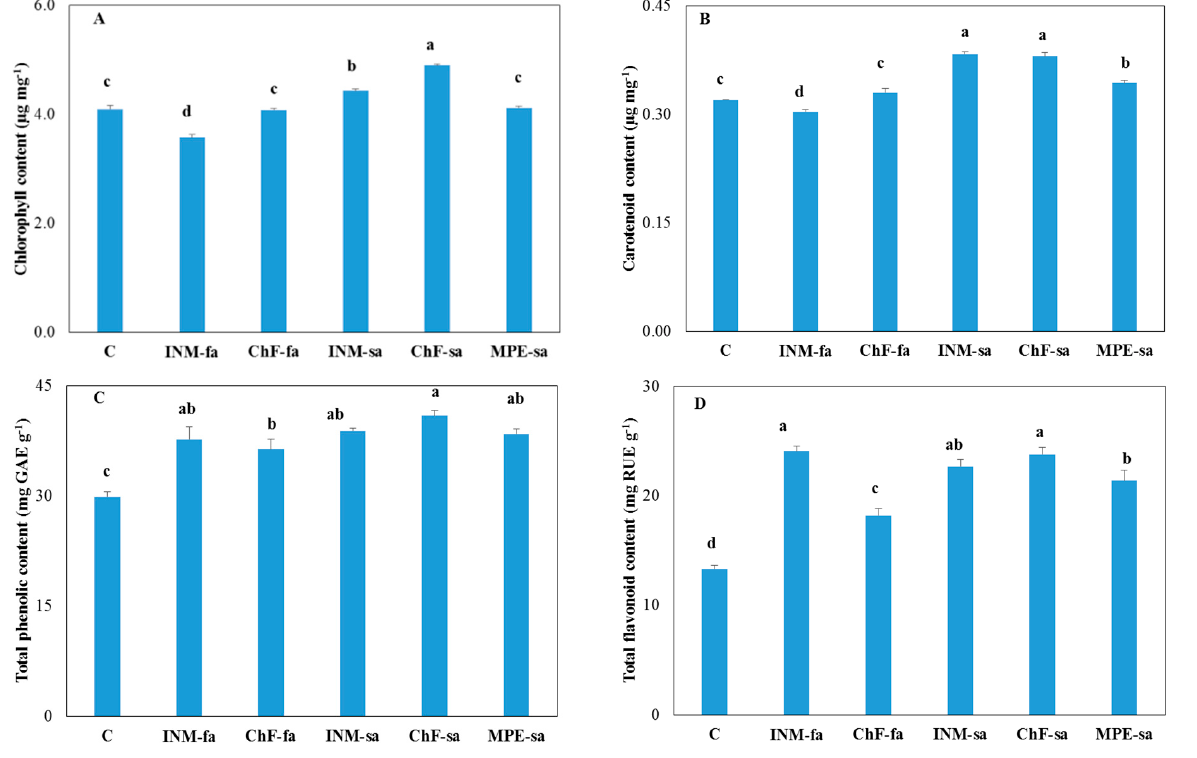
Figure 4. Effect of fertilization through different (root/foliar) application methods on: ( A ) leaf chlorophyll; ( B ) carotenoid; ( C ) total phenol; ( D ) total flavonoid content of Origanum microphyllum . C: control (water); INM: integrated nutrient management (INM) by foliar (INM-fa) or soil application (INM-sa); ChF: conventional fertilization by foliar (ChF-fa) or soil application (ChF-sa); MPE-sa: mixture of plant extracts as biostimulant by soil application. Values represent the mean of three replicates ± SEM. Within each plot different letters indicate significant differences.